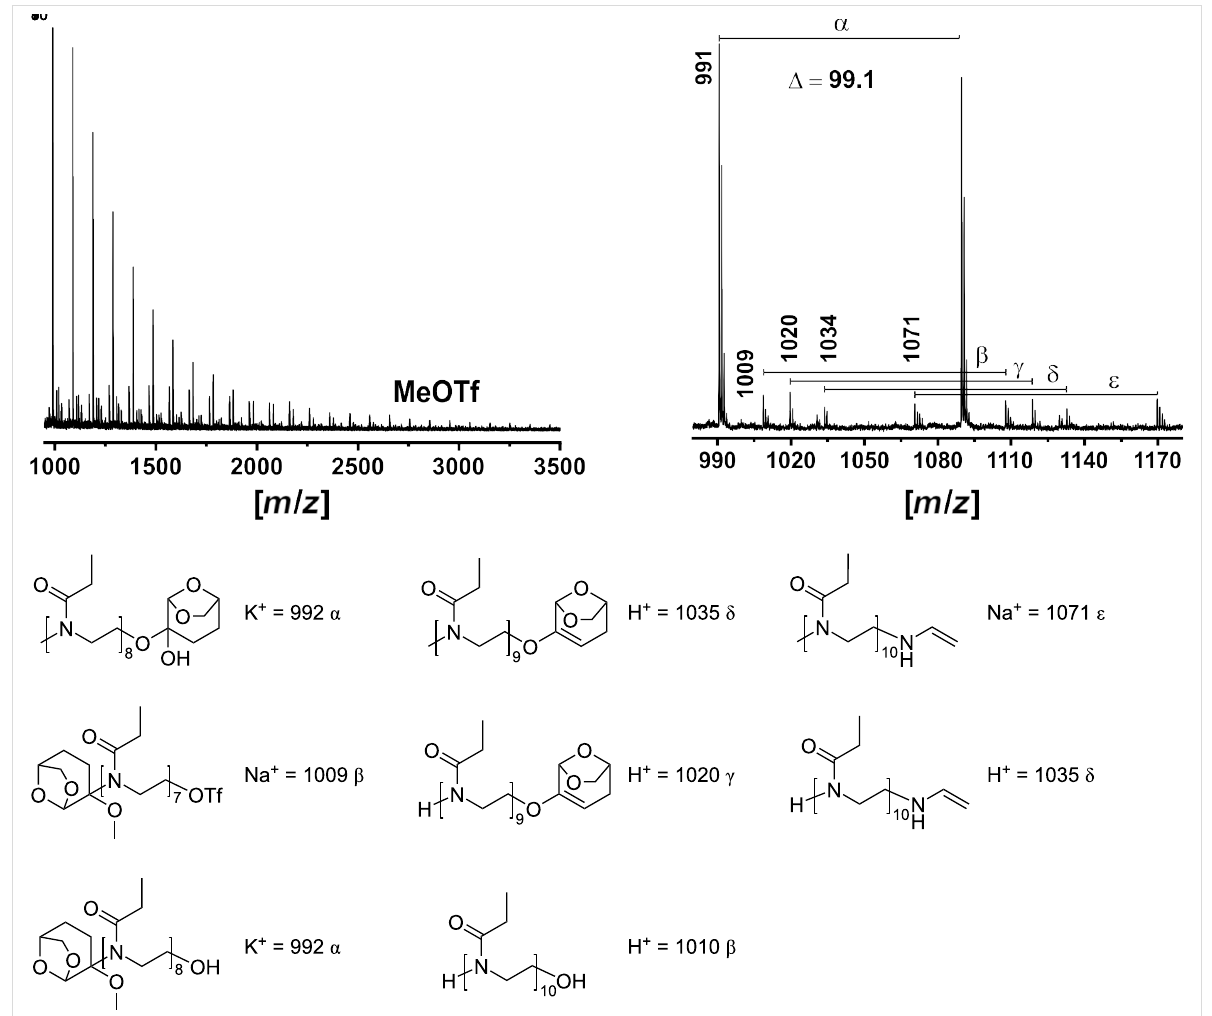
Figure 3: MALDI-TOF mass spectrometry analysis of the poly(2-ethyl-2-oxazoline) initiated with methyl triflate in DLG at 90